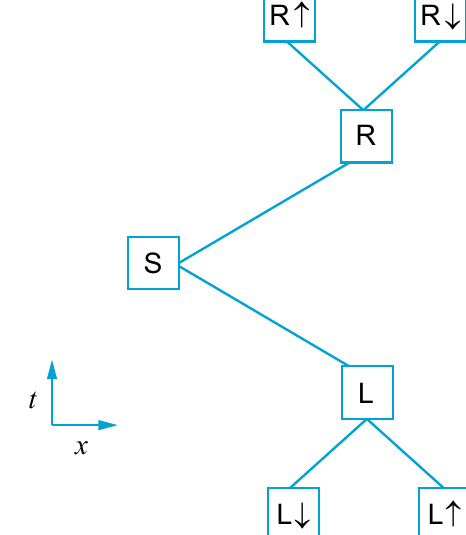
Figure 1: Spacetime diagram of the standard Einstein- Podolsky-Rosen-Bell experiment.